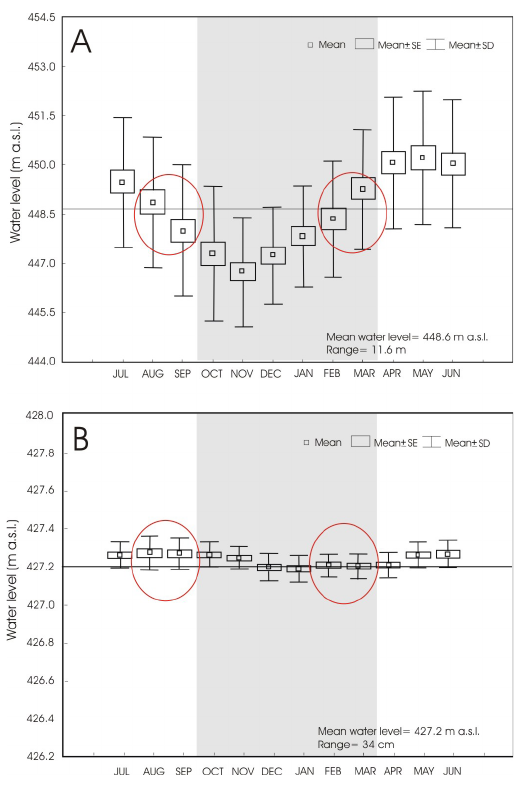
Figure 1. Hydraulic cycle of Barra Bonita (A) and Bariri (B) reservoirs. Barra Bonita is an accumulation reservoir, and Bariri is a run-of-the-river reservoir. The solid horizontal line is the yearly mean water level (m a.s.l.). Range is the yearly water level fluctuation. Red circles indicate the best “index period” corresponding